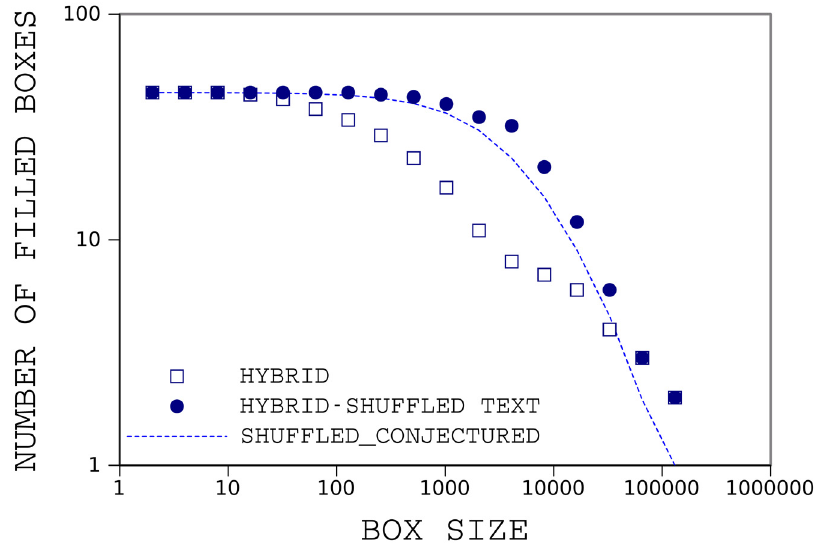
Fig 7. Results of box counting for distribution of HYBRID in the original and shuffled text. HYBRID is an important word in the book, The Origin of Species . So, there is a considerable difference between box- counting of this word in the original and shuffled